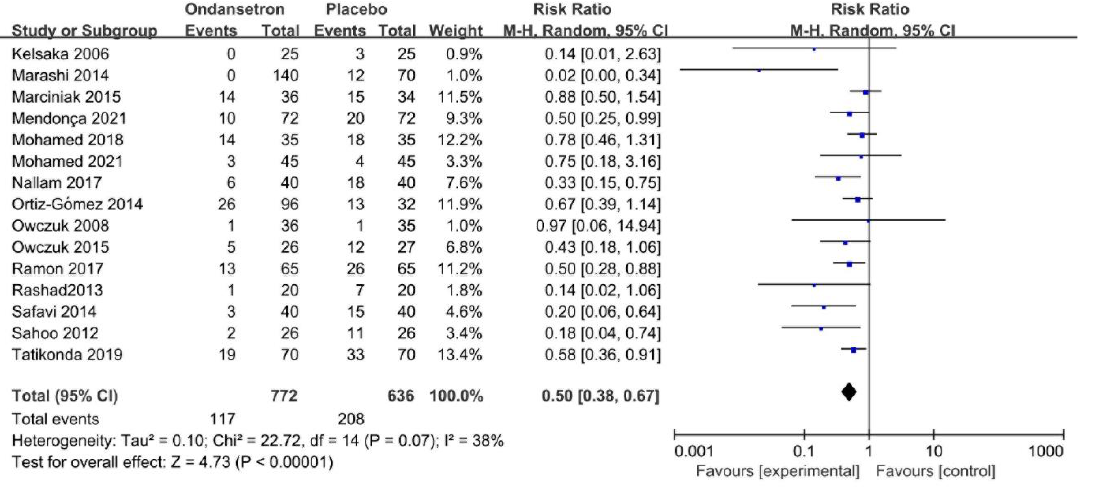
Figure 5. Forest plot of the pooled analysis showing the number of patients who required vaso-